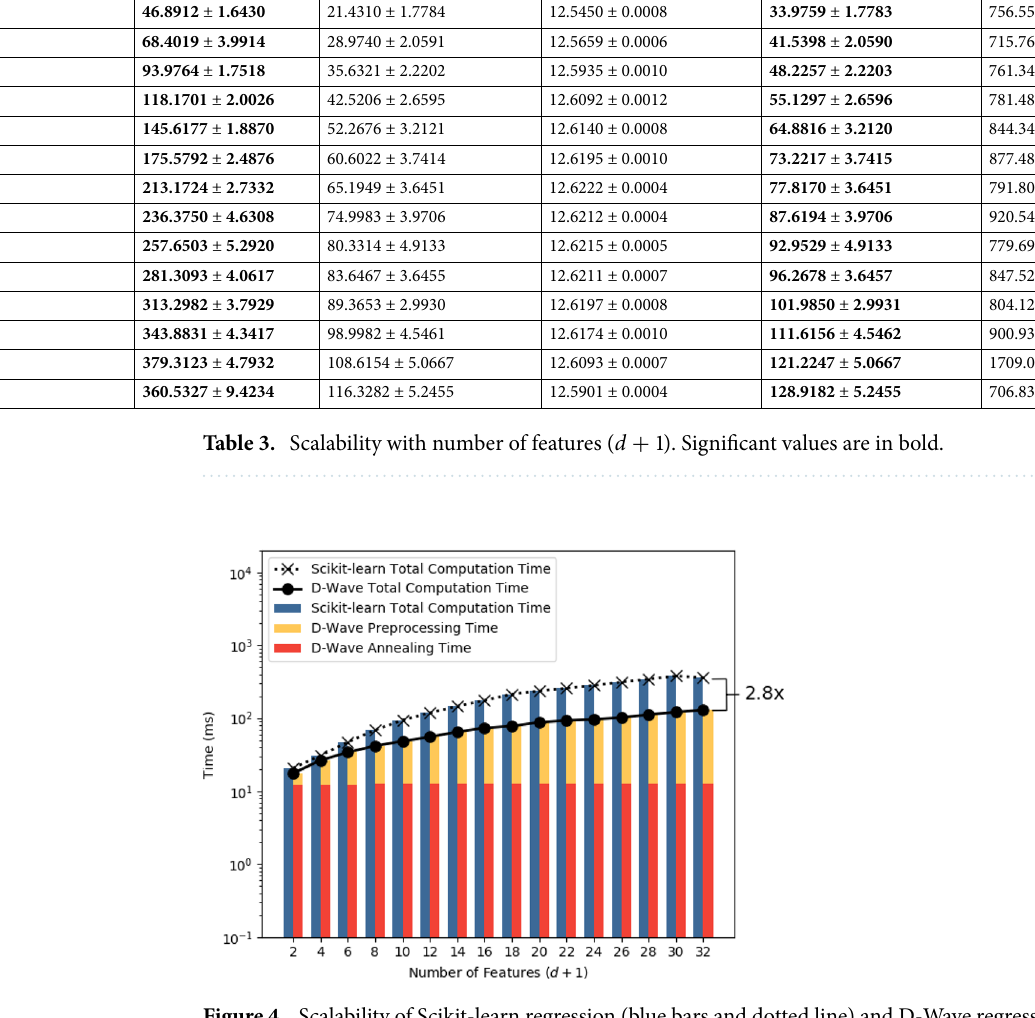
1 ), ranging from 2 to 32. The + speedup using D-Wave when ×